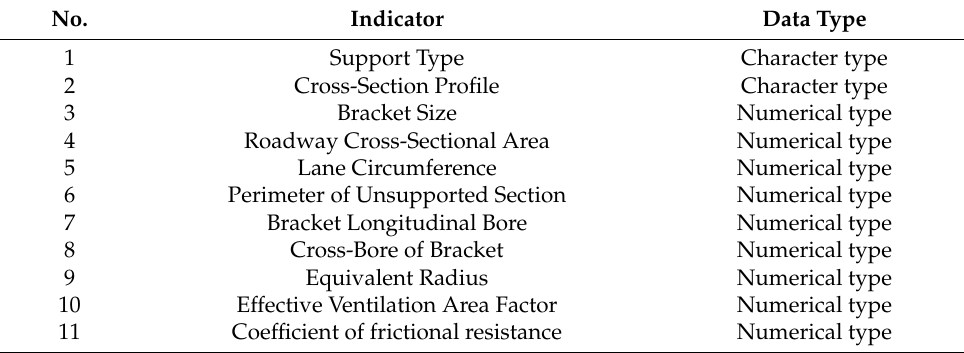
Figure 5. System of indicators for predicting frictional resistance coefficients in mines. Table 1. Data categories of the study sample.